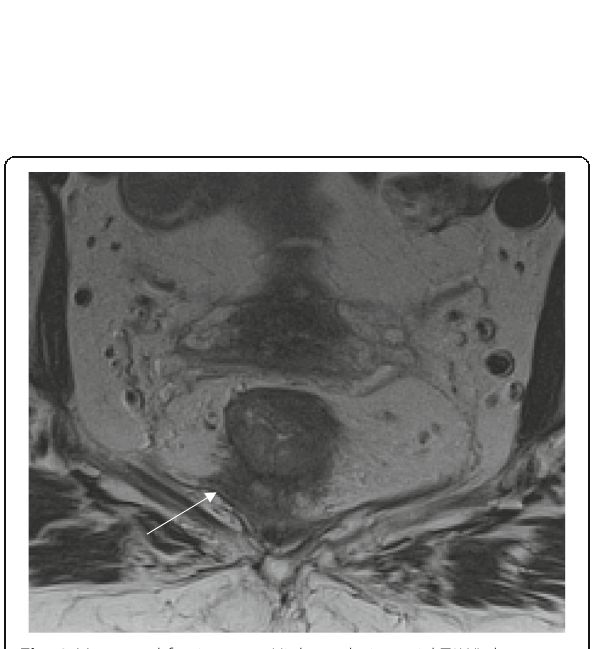
Fig. 2 Mesorectal fascia status. High-resolution axial T2WI shows a semiannular tumor infiltrating the mesorectal fat and threatening the mesorectal fascia (arrow)